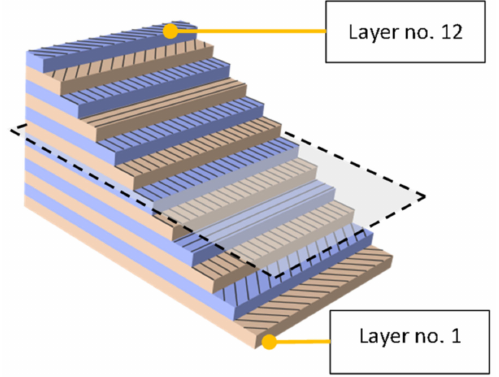
Figure 2. Ply-by-ply model